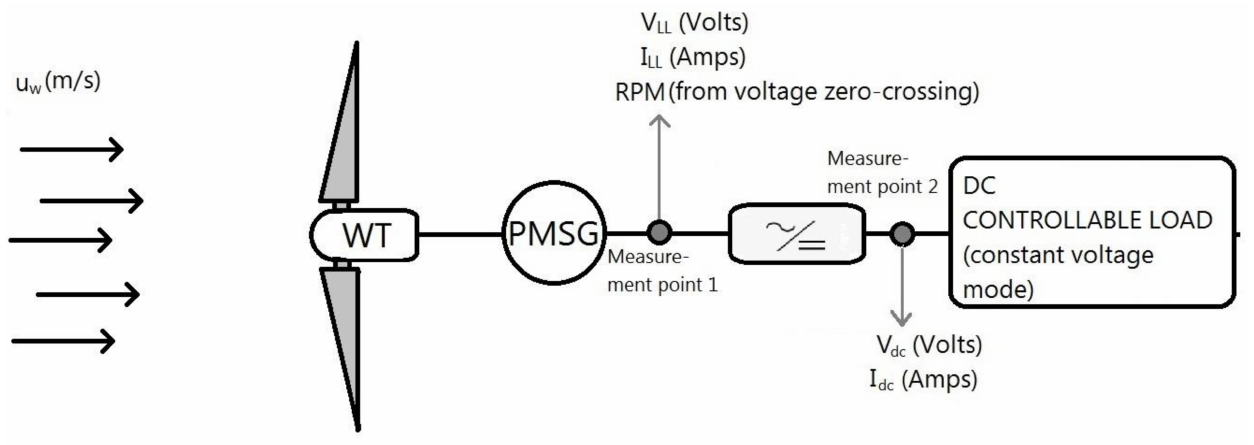
Figure 4. Configuration of DC-controllable load tests in wind